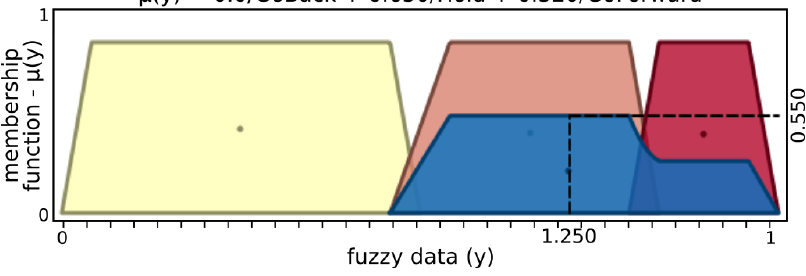
Figure 10. Input sets of status.